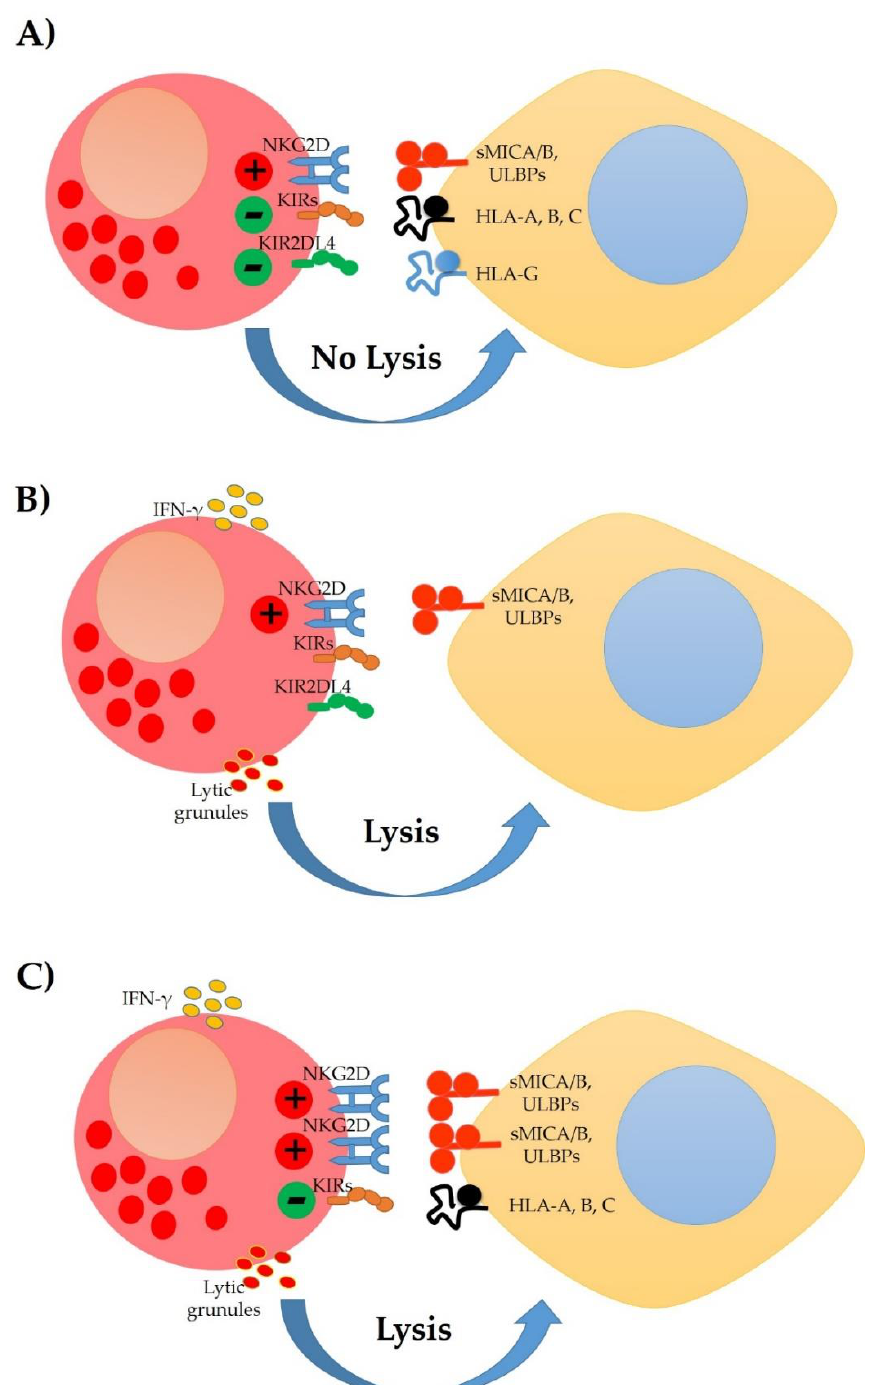
Figure 1. Natural killer (NK) cells express activator and inhibitory receptors; their activity depends on balancing these interactions with their respective ligands. ( A ) When signalling via inhibitory receptors exceeds signalling via activating receptors, the activation of NK cells is inhibited, and tolerance is generated. ( B ) When target cells decrease the expression of inhibitory ligands (HLA-A, B, C) and increase the expression of stimulatory molecules (MICA/B, ULBPs) and these interact with the activating receptors of NK cells such as NKG2D, the result is receptor activation that release cytokines from NK cells and cytotoxicity against the target cell. ( C ) When the target cells express a greater amount of stimulator molecules (MICA/B, ULBPs), the active signalling exceeds inhibitory signalling, leading to NK cells ’ activation.